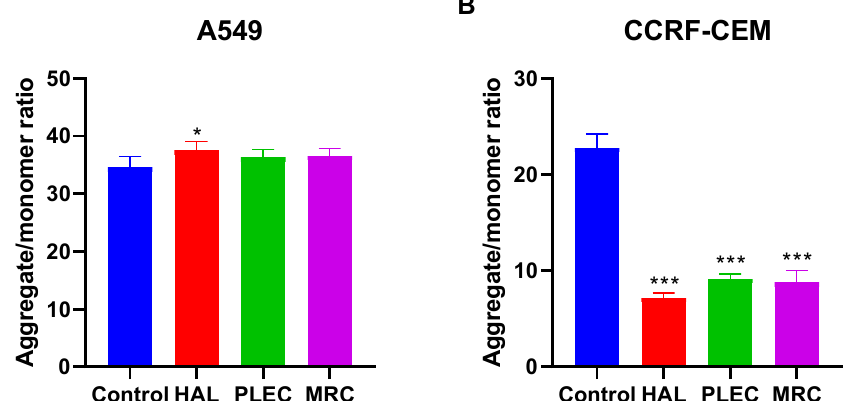
Figure 5. Changes in MMP of A549 ( A ) and CCRF-CEM ( B ) cells incubated with HAL, PLEC and MRC for 24 h. MMP is expressed as ratio of 530 nm/590 nm to 485 nm/538 nm (aggregates to monomer) fluorescence as quantified with a fluorescent plate reader after JC-1 staining. Results are presented as means ± SD. * p < 0.05, *** p < 0.001 vs. control cells.